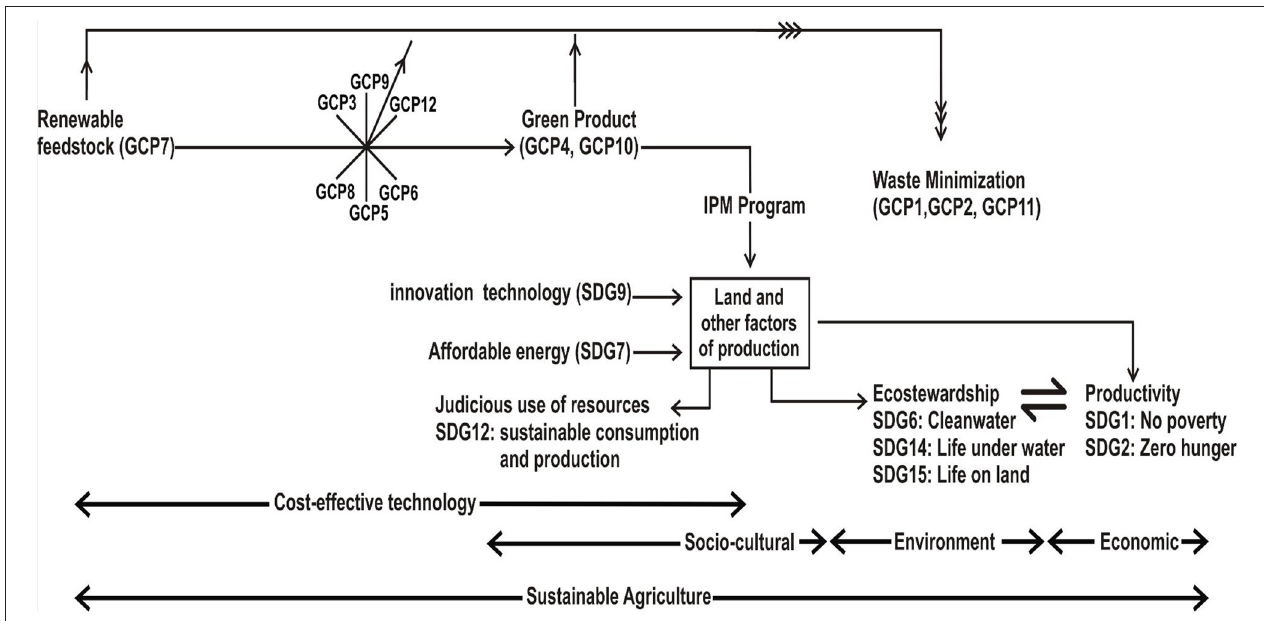
FIGURE 1 | A simplified diagram of biopesticide-driven commercial agriculture connecting green chemistry and sustainable development. Key: GCP1, Waste prevention; GCP2, Atom economy; GCP3, Less hazardous chemical synthesis; GCP4, Designing safer chemical; GCP5, Benign solvent and auxiliaries; GCP6, Energy efficiency; GCP7, Renewable feedstock; GPC8, Reduce derivatives; GPC9, Catalysis; GCP10, Design for degradation; GCP11, Real-time analysis; GCP12, Inherently safer